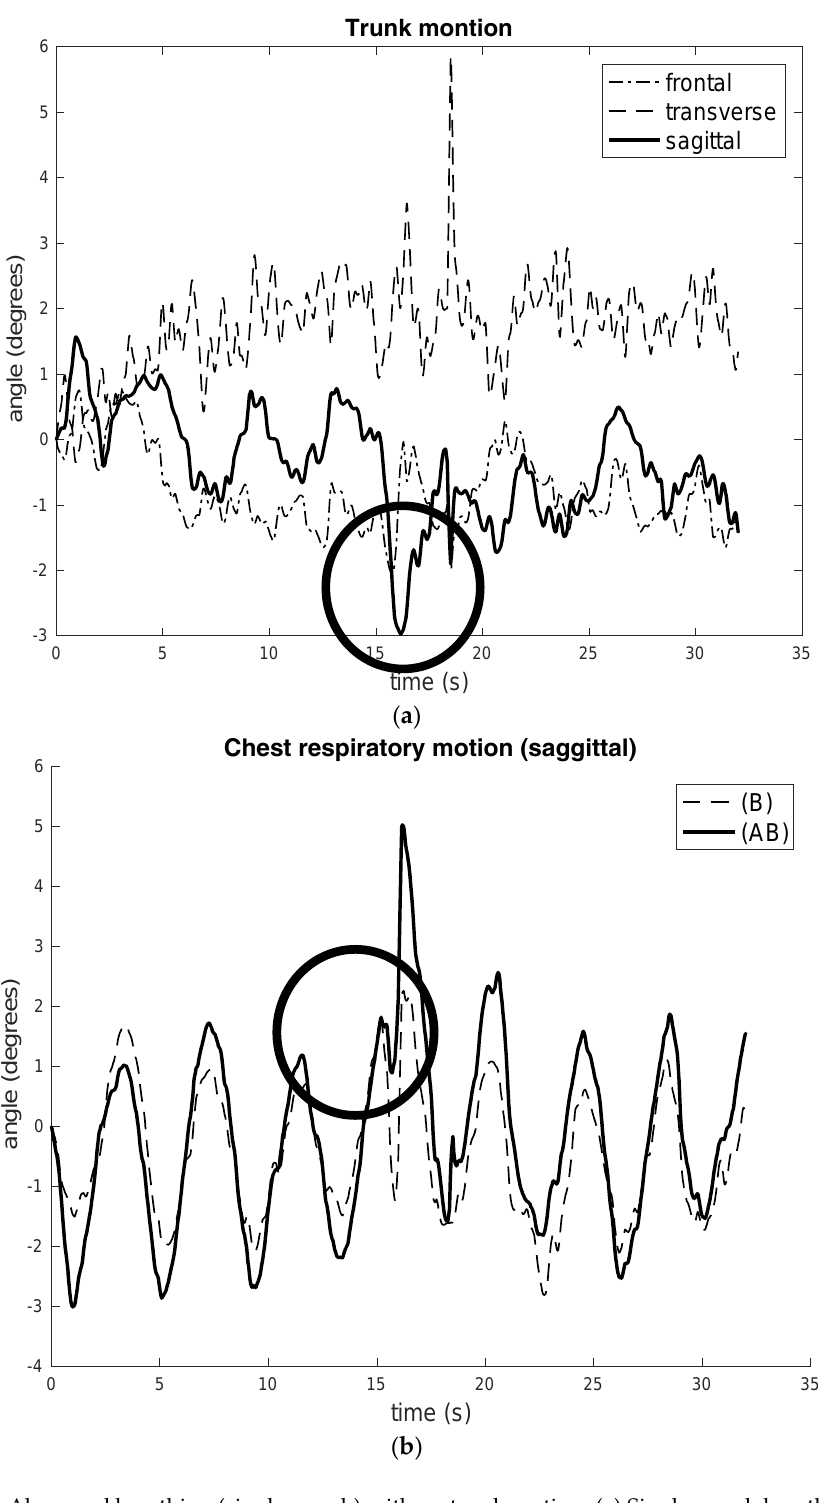
Figure 6. Abnormal breathing (single-cough) with no trunk motion: ( a ) Single-cough breathing with no trunk motion: The very clear coughing motions of trunk shows in the “Sagittal” plane; ( b ) The single coughing can be seen as short and sharp negative spikes, which have been indicated by a circle.